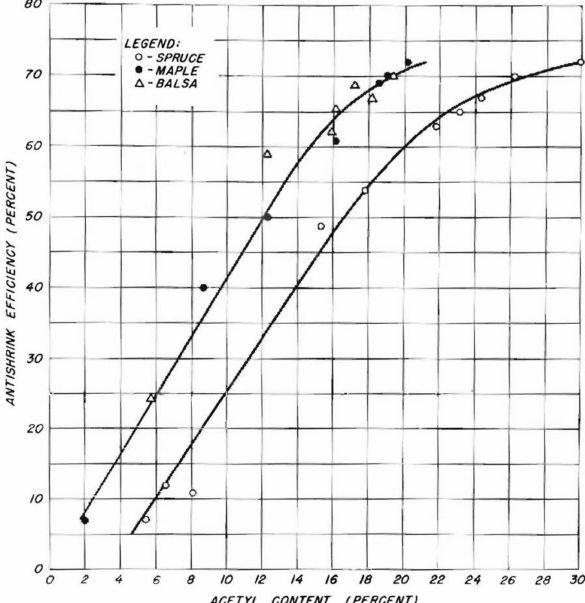
Figure 2. Relationship between the acetyl content and the antishrink efficiency of several species of wood